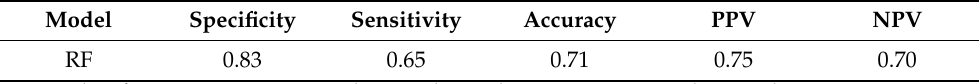
Table 2. Summary of the statistics parameters of the RF model (average between the five models).